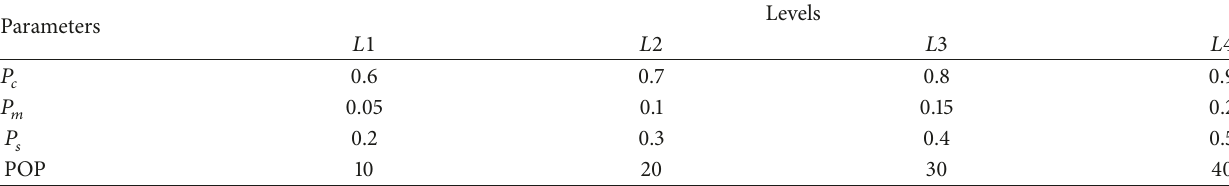
Table 3: Levels of parameters for